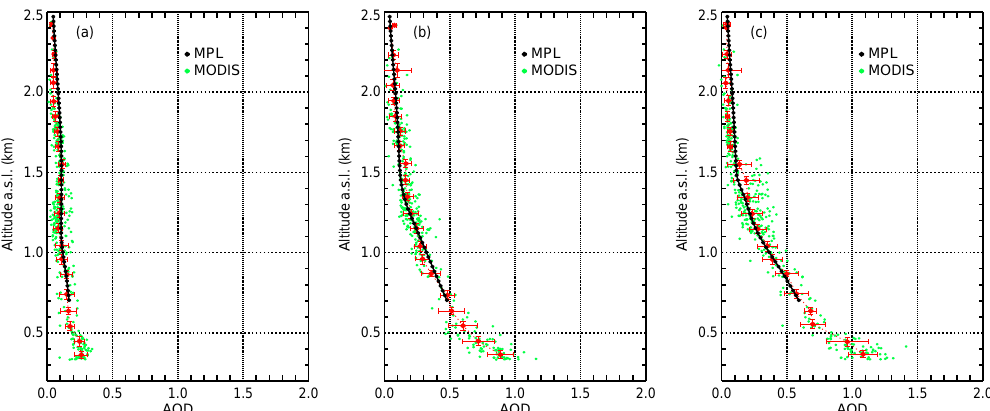
Figure 4. AOD at different altitudes derived from MODIS retrievals over the study region shown in Fig. 1a (green dots) and MPL (black dots) data on (a) 13 September 2013 at 06:00 coordinated universal time (UTC), (b) 26 March 2014 at 05:50UTC, and (c) 29 September 2013 at 06:00UTC. Red dots and horizontal bars represent mean MODIS AODs and standard deviations, respectively. Only those MODIS 5min granules with a sufficient amount of valid AOD data ( > 75%) are